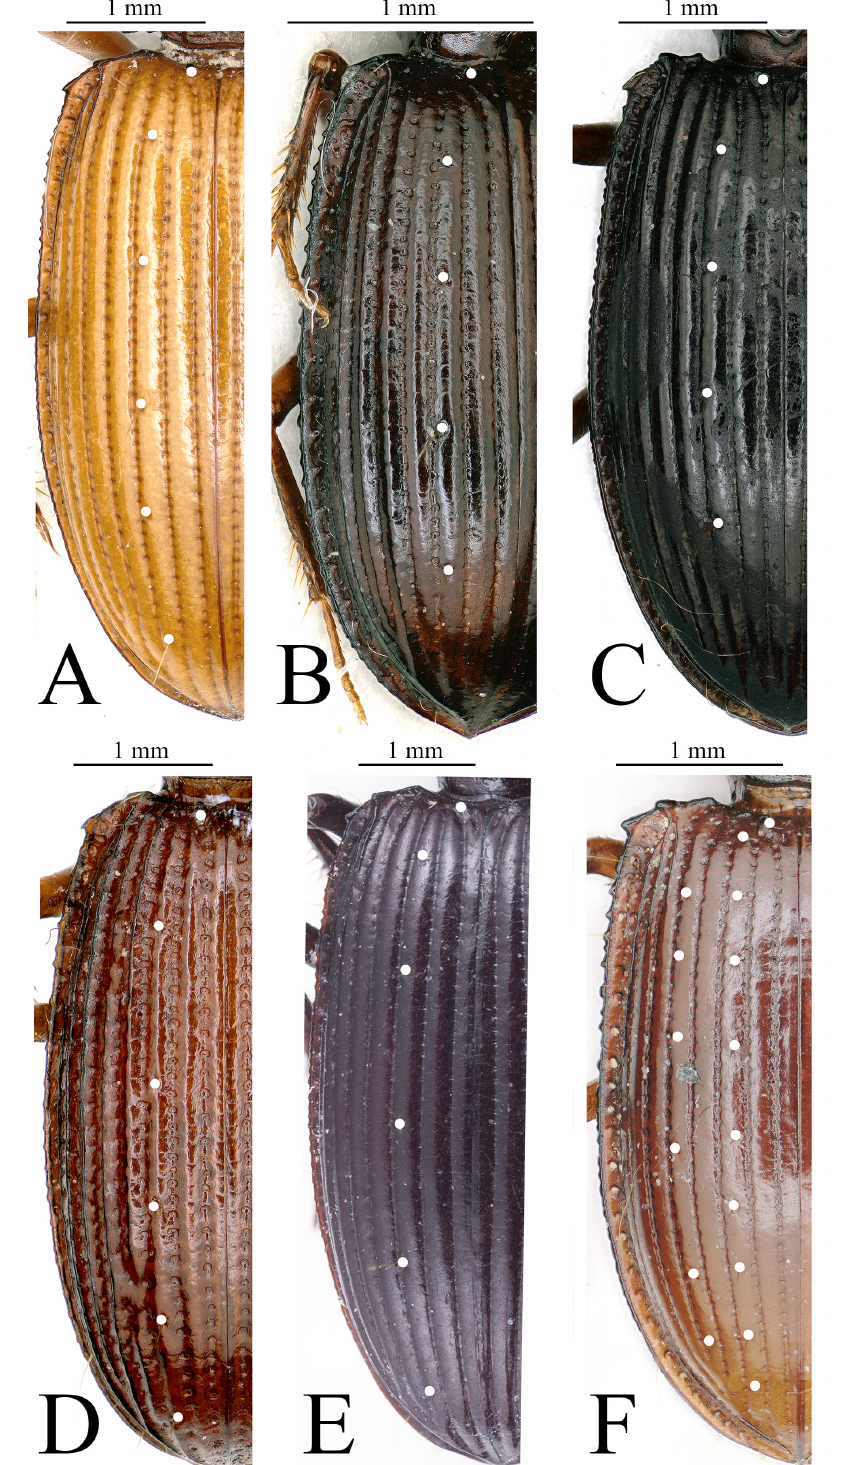
Fig. 4. Left elytron of species of Guiodytes Tian, 2013. A . G. deharvengi Tian, 2014. B . G. bedosae Tian, 2013. C . G. cavicola Tian, 2013. D . G. weii Huang & Faille sp. nov., holotype, ♂ (SCAU). E . G. yueliangensis Huang & Tian sp. nov., holotype, ♂ (SCAU). F . G. inexpectatus Tian & Zhou sp. nov., holotype, ♀ (SCAU). Dorsal pores indicated by white